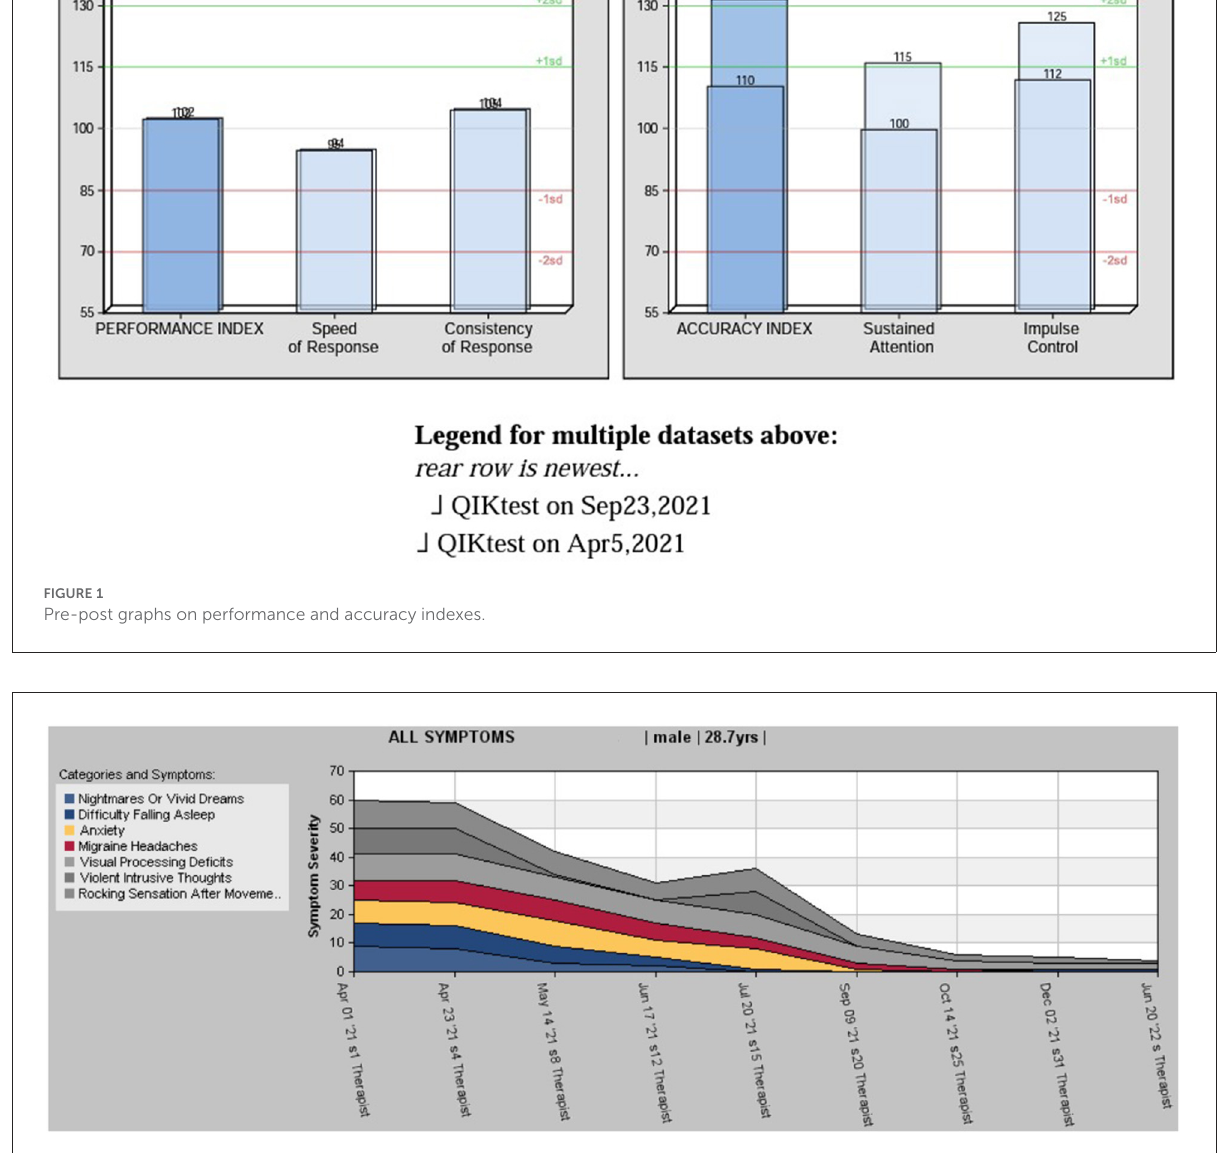
FIGURE2 Stacked chart of symptom